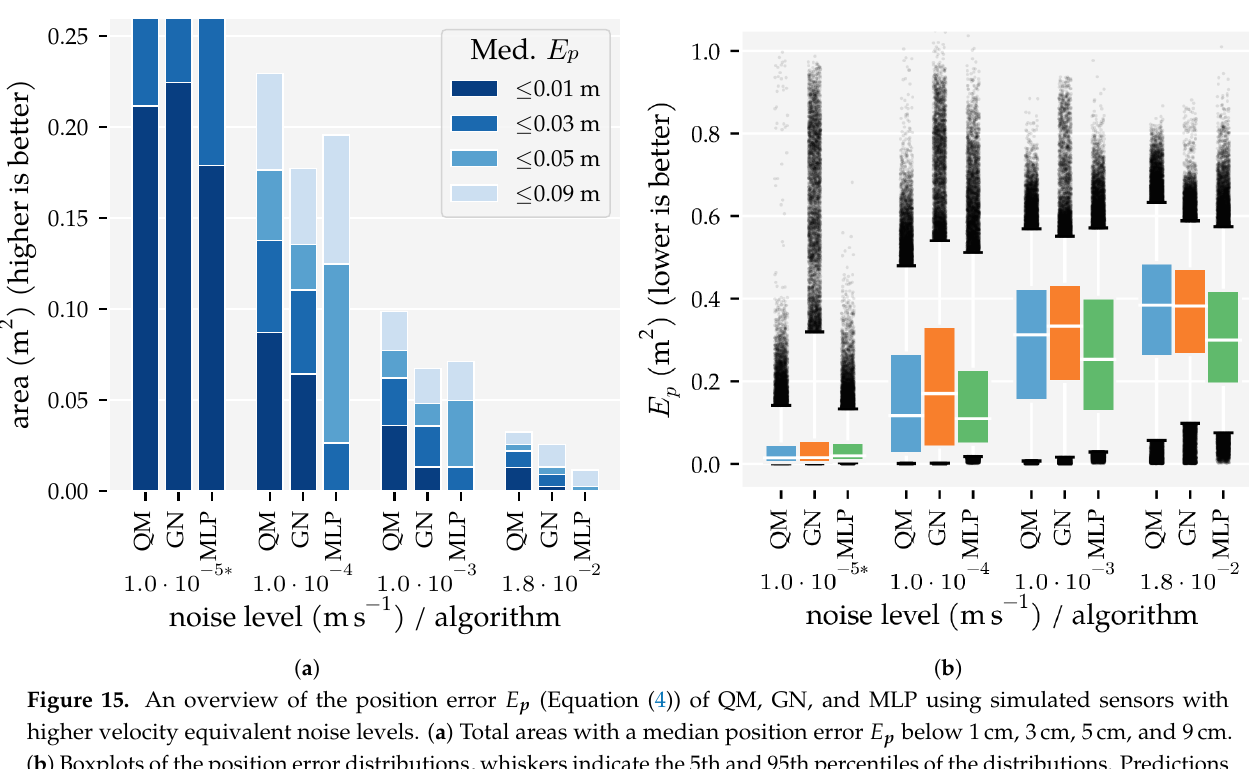
Figure 15. An overview of the position error E p (Equation (4)) of QM, GN, and MLP using simulated sensors with higher velocity equivalent noise levels. ( a ) Total areas with a median position error E p below 1cm, 3cm, 5cm, and 9cm. ( b ) Boxplots of the position error distributions, whiskers indicate the 5th and 95th percentiles of the distributions. Predictions with errors outside these percentiles are shown individually. The values for σ = 1.0 × 10 − 5 ms − 1 are based on the D s = 0.01 condition in Analysis Method 1. The (x + y) sensor configuration was used. The MLP was re-trained for each noise level. Both the MLP and GN used the optimal hyperparameter values from the D s = 0.01 condition of Analysis Method